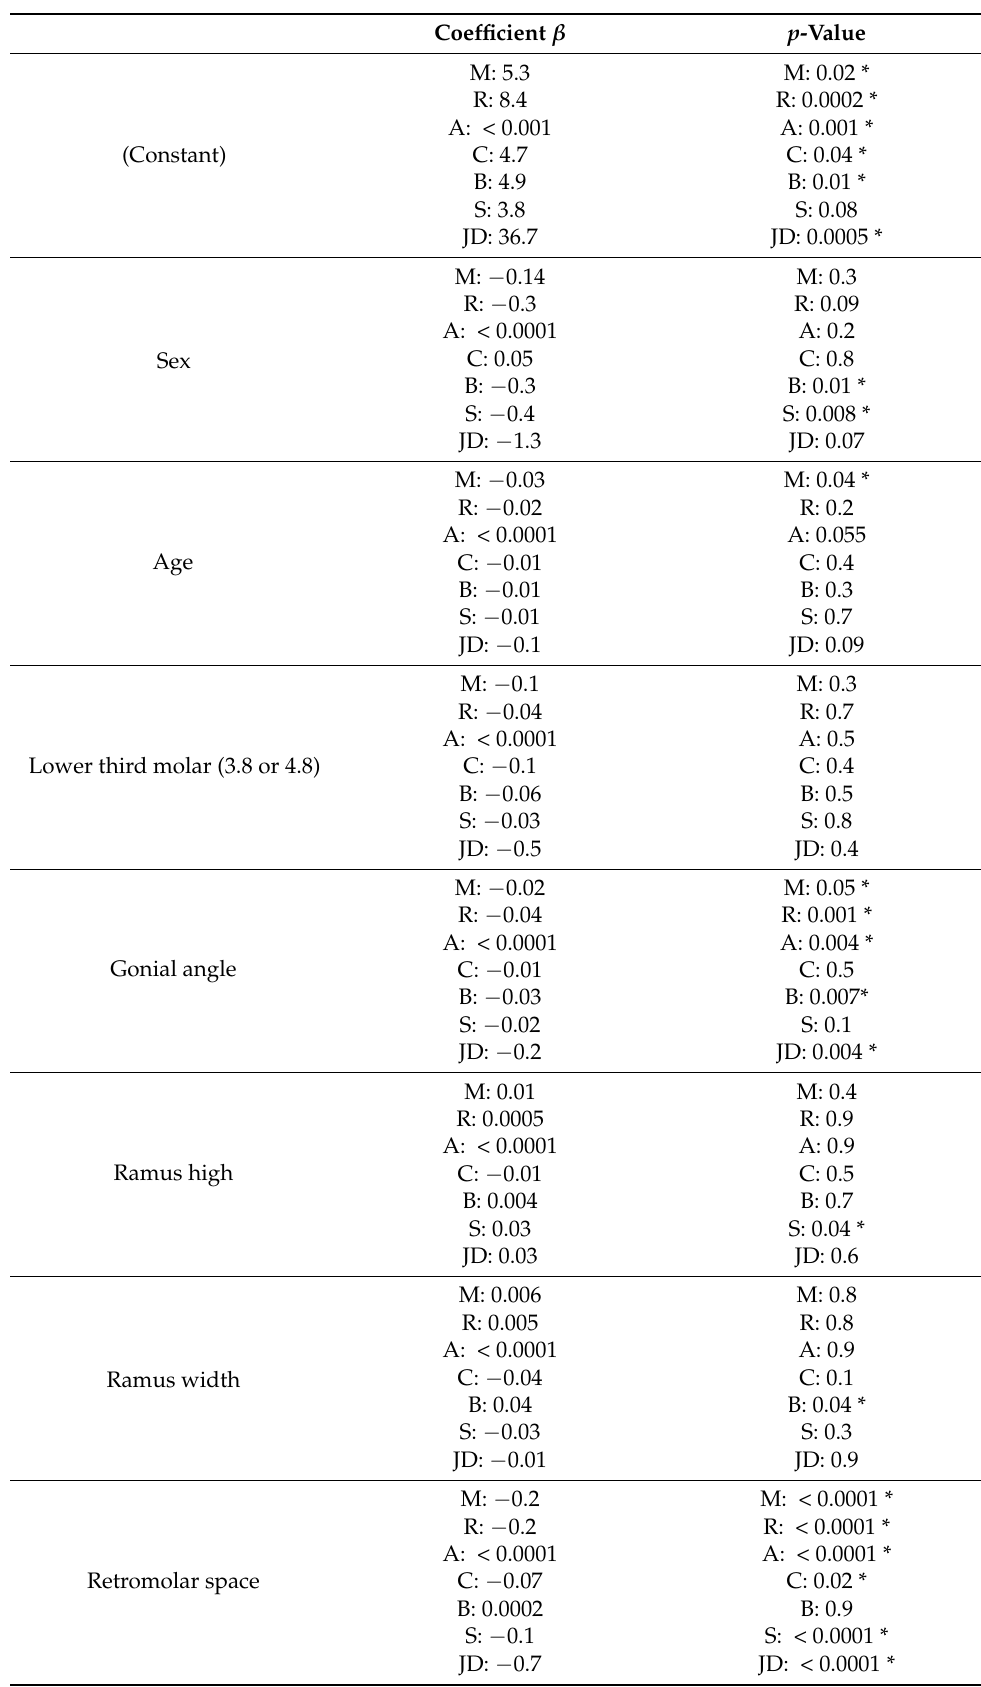
Table 4. Multiple linear regression model for the primary outcome variables (M, R, A, C, B, S,